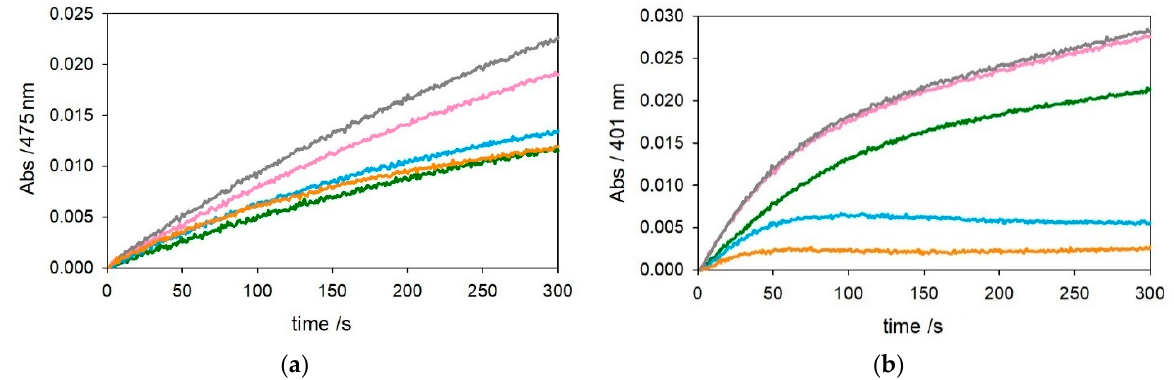
Figure 1. Kinetic profiles of DA (3 mM, panel ( a )) and MC (3 mM, panel ( b )) oxidation with time in 50 mM HEPES buffer at pH 7.4 and 20 °C in the presence of Cu II alone (25 µM, green trace) and with 1 equiv. A β 1–16 (25 µM, pink), 2 equiv. A β 1–16 (50 µ M, grey), 1 equiv. A β 4–16 (25 µ M, light blue), and 2 equiv. A β 4–16 (50 µ M, orange).